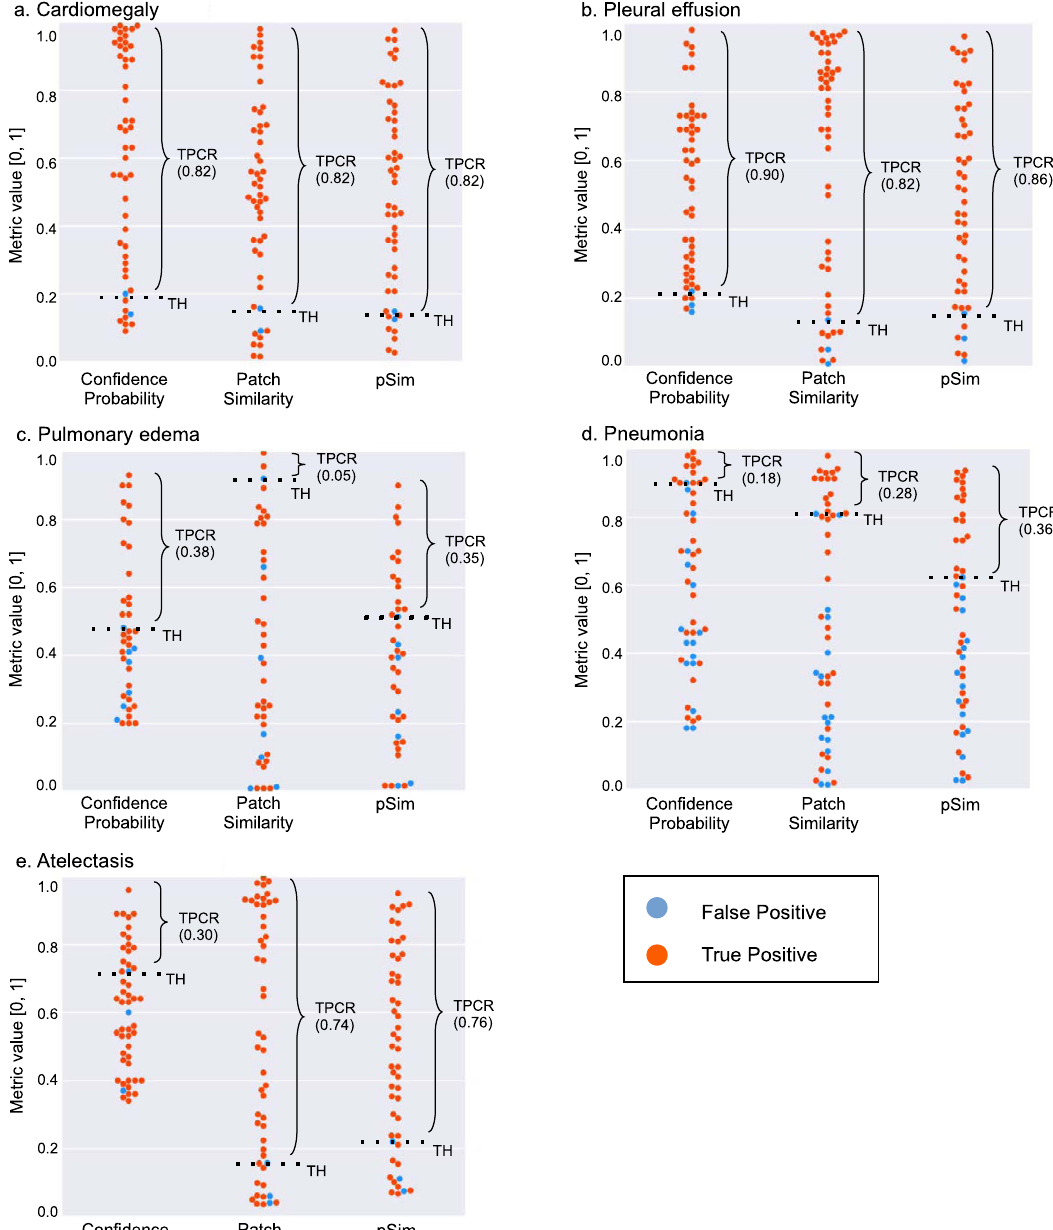
Fig. 8 Performance comparison of Con fi dence Probability, Patch Similarity, and pSim in assigning true-positive model output labels for cardiomegaly, pleural effusion, pulmonary edema, pneumonia, and atelectasis. We compared the true positive capture rate (TPCR) performance for each of the fi ve clinical output labels, using con fi dence probability alone (re fl ecting the global probability distribution of the output labels), patch similarity alone (re fl ecting the focal spatial localization of the output labels), and pSim (re fl ecting the harmonic mean between the con fi dence probability and patch similarity, as per Fig. 1). These results are noteworthy in that the two model output labels that re fl ect high inter-rater agreement of imaging fi ndings — a cardiomegaly and b pleural effusion, as per Fig. 7 — show good agreement between the three con fi dence-level metrics, with high TPCR ’ s for each. For the two output labels that show lower inter-rater agreement per Fig. 7 — c pulmonary edema and d pneumonia — pSim performance signi fi cantly exceeds that of patch similarity for both, and that of con fi dence probability for pneumonia but not pulmonary edema. This difference is likely attributable to the fact that patch similarity is more sensitive for the detection of focal, regional imaging fi ndings (e.g., as seen with the clinical diagnosis of pneumonia), whereas con fi dence probability is more sensitive for the detection of global fi ndings (e.g., as seen with the clinical diagnosis of pulmonary edema). The results for e atelectasis, typically a more focal than global fi nding on CXR, may be similarly